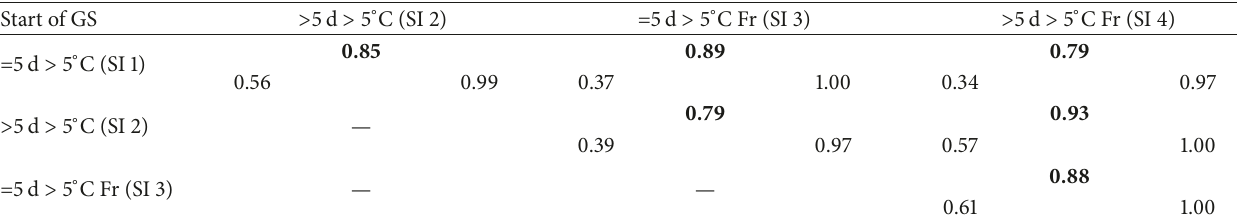
Table 2: Pearson’s correlation coefficient ( 𝑟 ) for combination of the start indices of the growing season. Single bold values show the mean coefficients over northern China, and the paired values below show the minimum (left) and maximum (right)